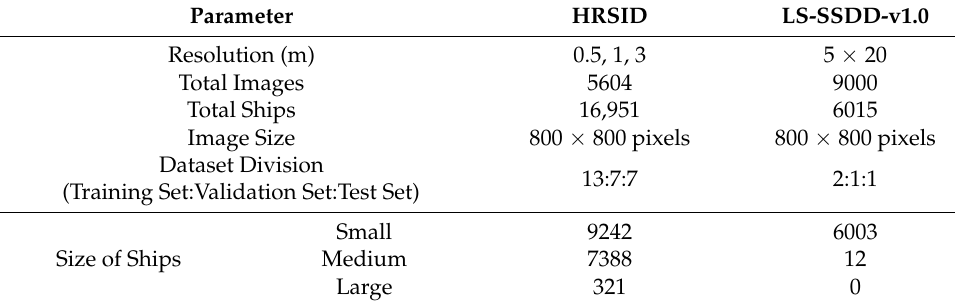
Table 1. Description of the two datasets